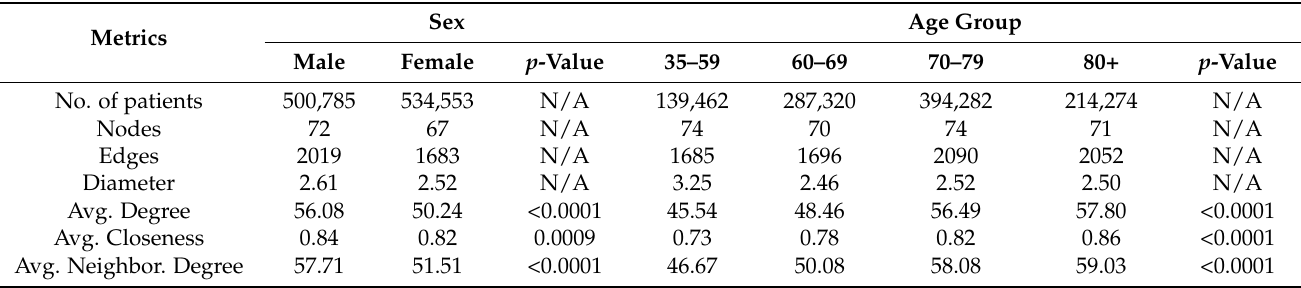
Table 3. Metrics of sex- and age-specific